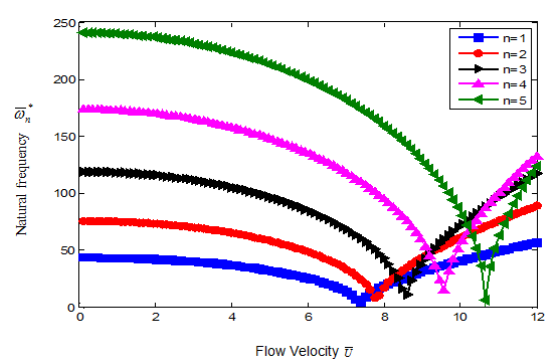
Figure 7. Absolute values of the transverse natural frequencies profile for the case R i = 0 . 41 m,L = 2 km,γ = 0 . 02 ,δ 0 . 3721 , Θ = 100 ◦ C,χ = − 0 . 2